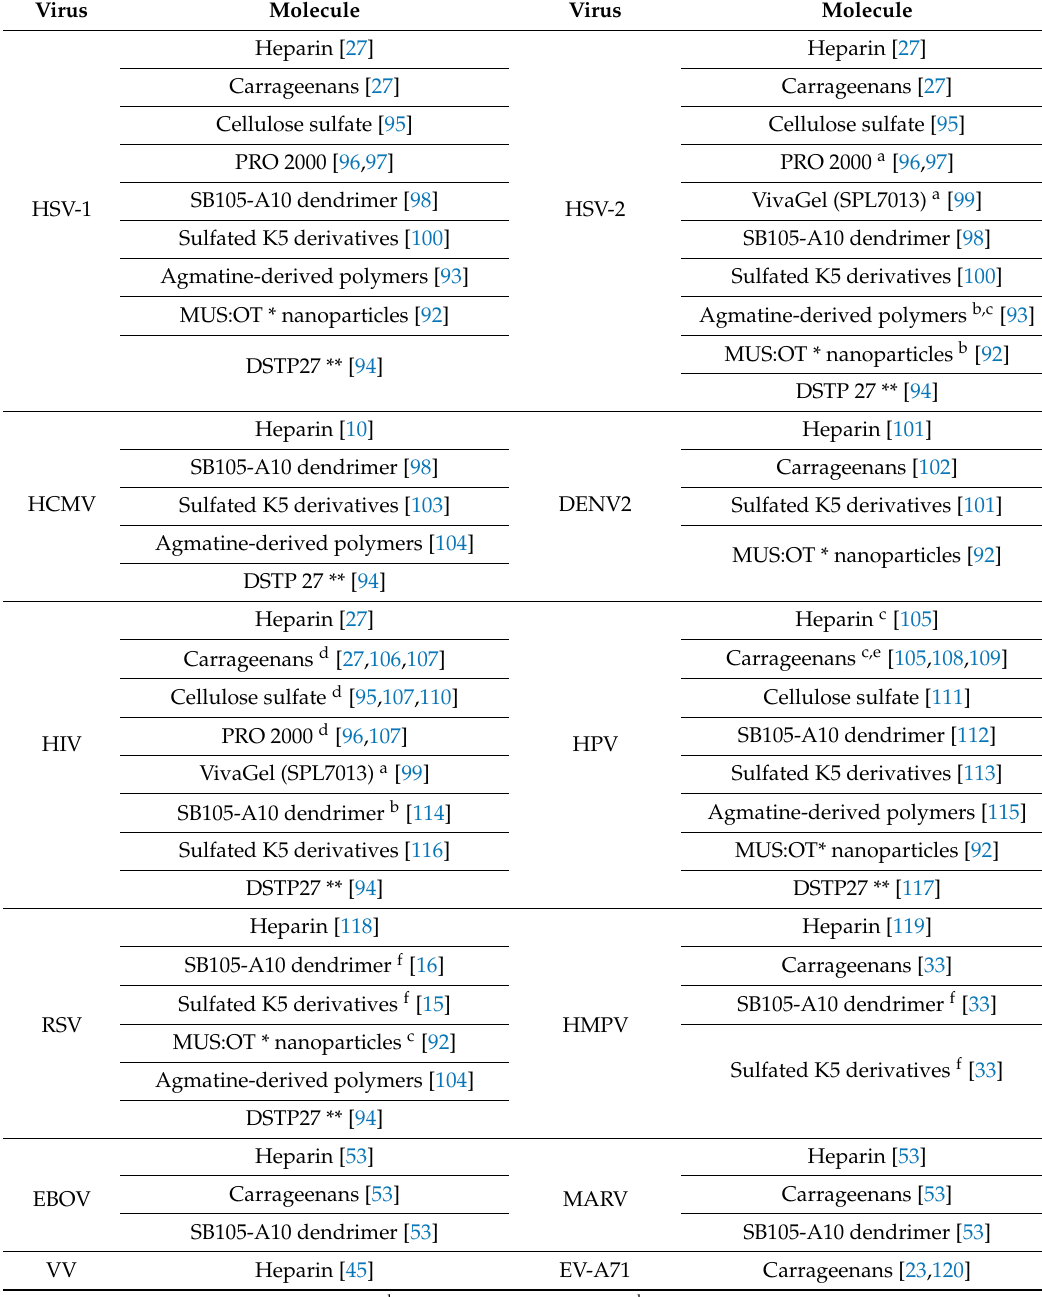
Table 2. Compounds showing broad-spectrum activity by interfering with virus–HSPG interaction.